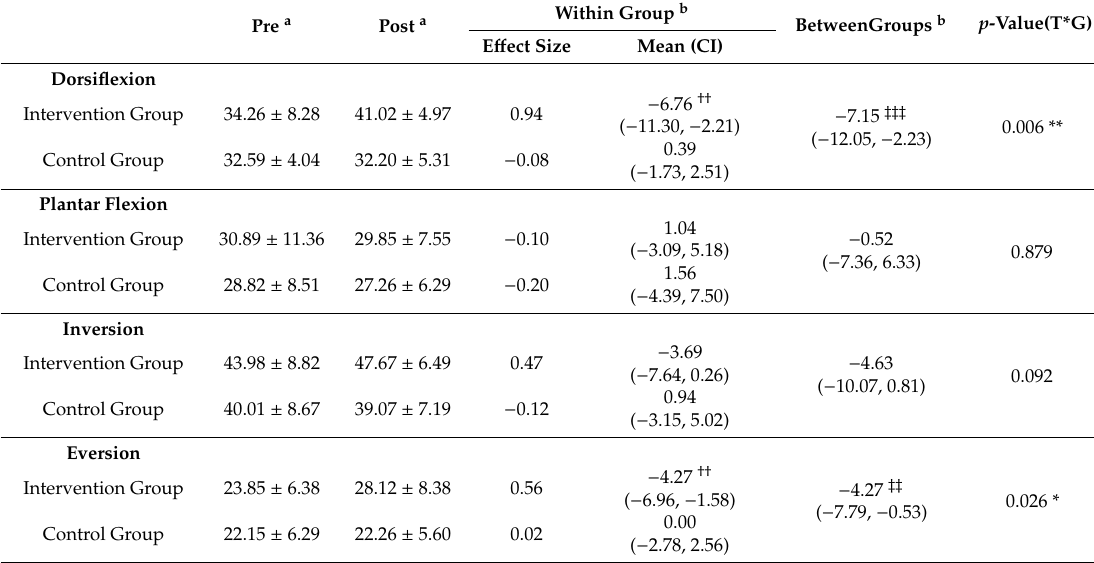
Table 4. The changes in ankle ROM (range of